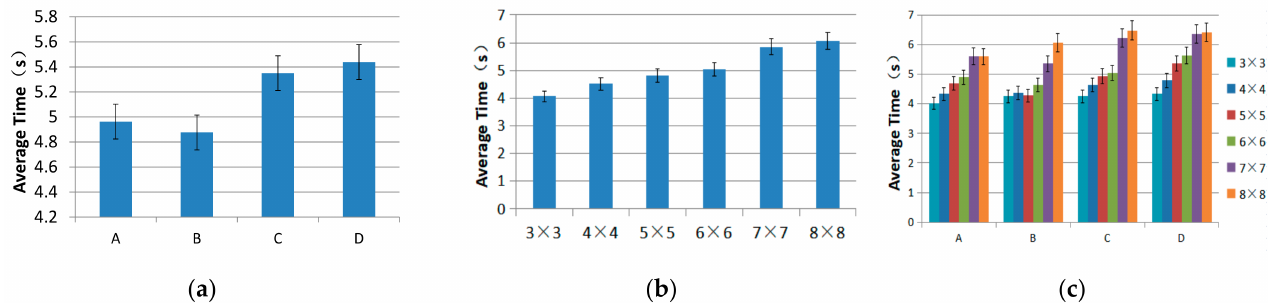
Figure 9. Average times of Experiment 2. Error bars represent a 95% confidence interval: ( a ) average selection time with different regions; ( b ) average selection time with different target size levels; and ( c ) average selection time for different target size levels under different regions (A, B, C, and D).